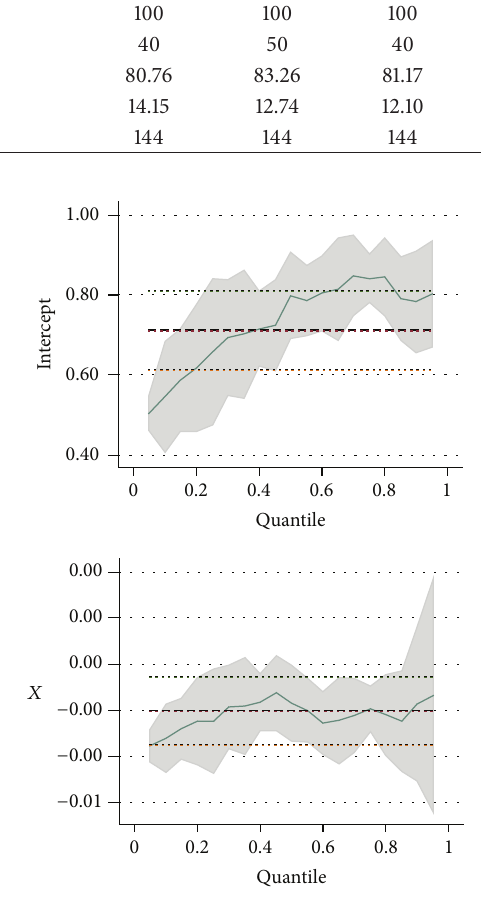
Figure 1: Quantile regression diagram.